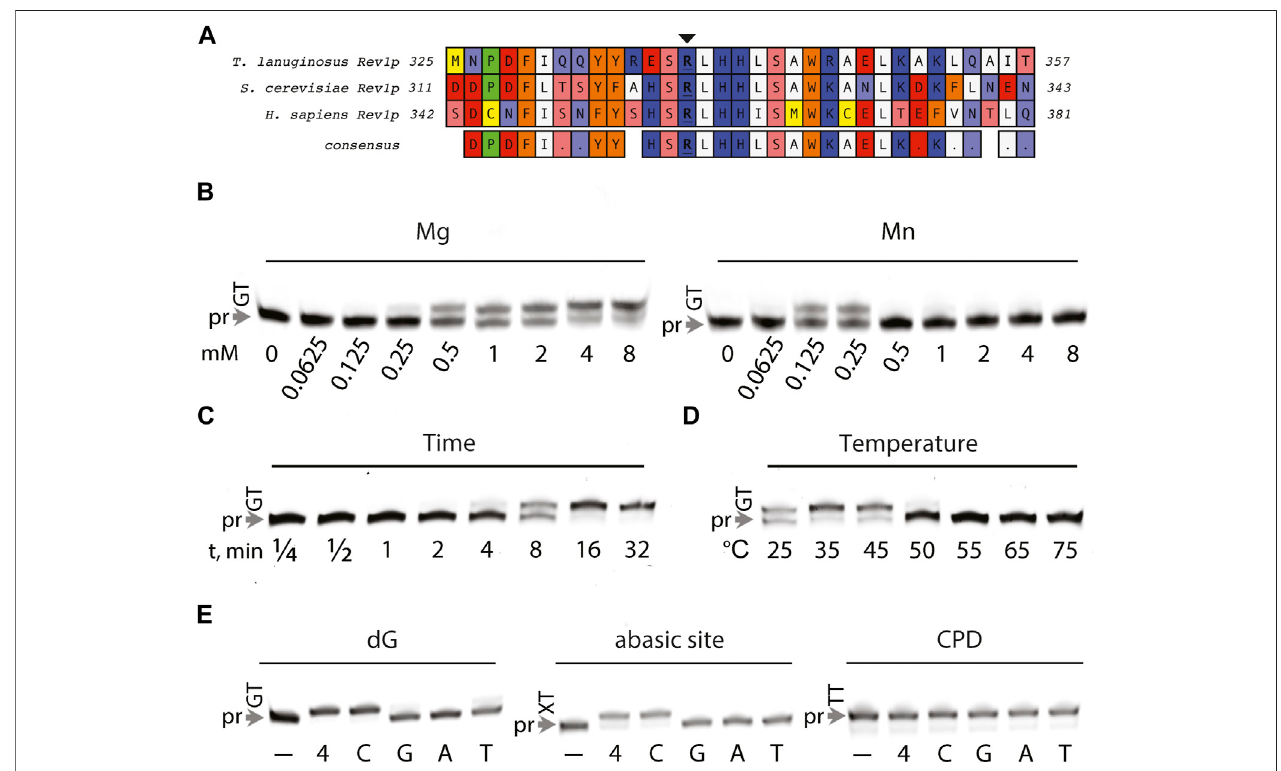
FIGURE 7 | Characterization of DNA synthesis by T. lanuginosis Rev1. (A) Sequence alignment between REV1 orthologs ( Thermomyces lanuginosus, Saccharomyces cerevisiae, and Homo sapiens ), illustrating the conserved arginine residue (indicated with an arrow) required for protein-templated DNA synthesis (B) Serial 1:1 dilutions of Mg 2+ and Mn 2+ metal ions presentwithin 6-FAM primer extension reactions, starting at 8 mM Me 2+ . (C) Processivity was qualitatively assessed by varying the duration (minutes) of 6-FAM primer extension reactions. (D) Thermostability was evaluated by monitoring DNA synthesis activity at varied temperature (25 – 75 ° C). (E) Lesionbypass activityfor undamaged(dG),abasicsite, and CPDtemplate base/lesionidentities wasexaminedinthepresenceofeithernone( – ),100 µM dNTPs (4), 100 µM dCTP (C), 100 µM dGTP (G), 100 µM dATP (A), 100 µM dTTP